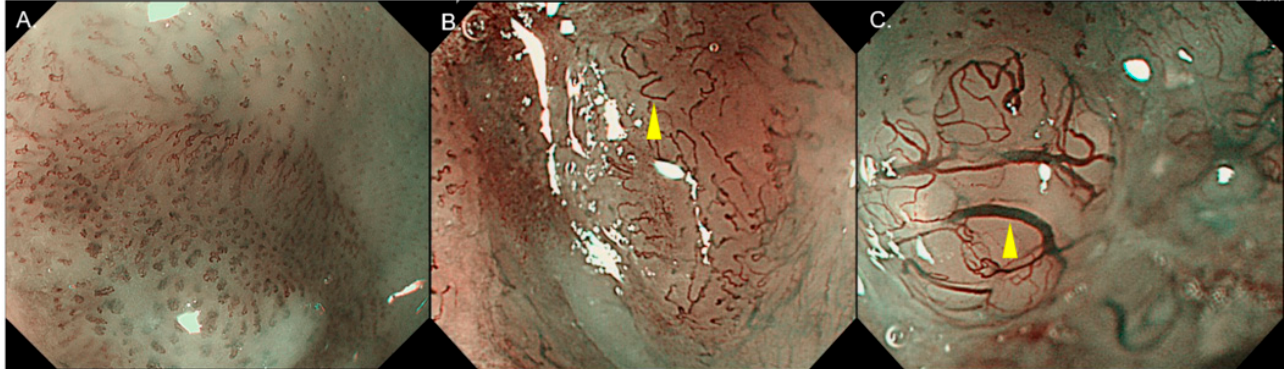
Figure 1. Typical images of B1, B2, and B3 vessels in the JES’s IPCL classification in ME-NBI. ( A ) B1 vessel. ( B ) B2 vessel (yellow arrow). ( C ) B3 vessel (yellow arrow). JES, Japan Esophageal Society; IPCL, intrapapillary capillary loop; ME-NBI, magnifying endoscopy with narrow band imaging.